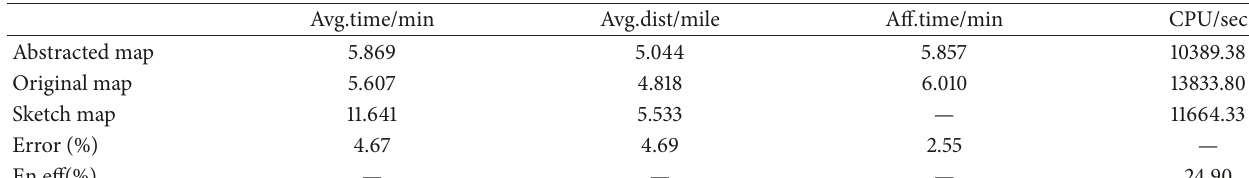
Table 2: Experiment validation results.